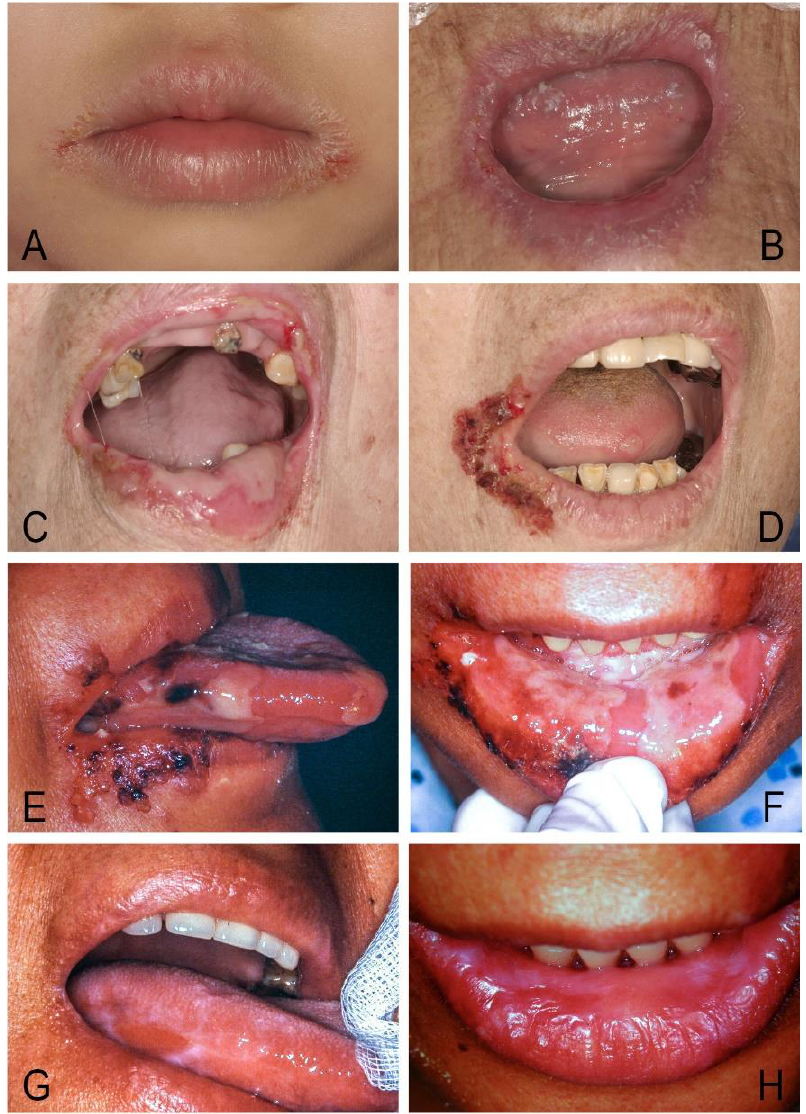
Figure 8. ( A ) Juvenile juxtavermillion candidosis in a healthy 4-year-old girl. ( B – D ) Cheilocandidos with intraoral candidosis in three immunocompromised patients. ( E , F ) Candidosis-related angular cheilitis and oral ulcers before therapy in a 60-year-old woman with diabetes and uremia. ( G , H ) Complete response to nystatin tablets and clotrimazole cream 10 days later.